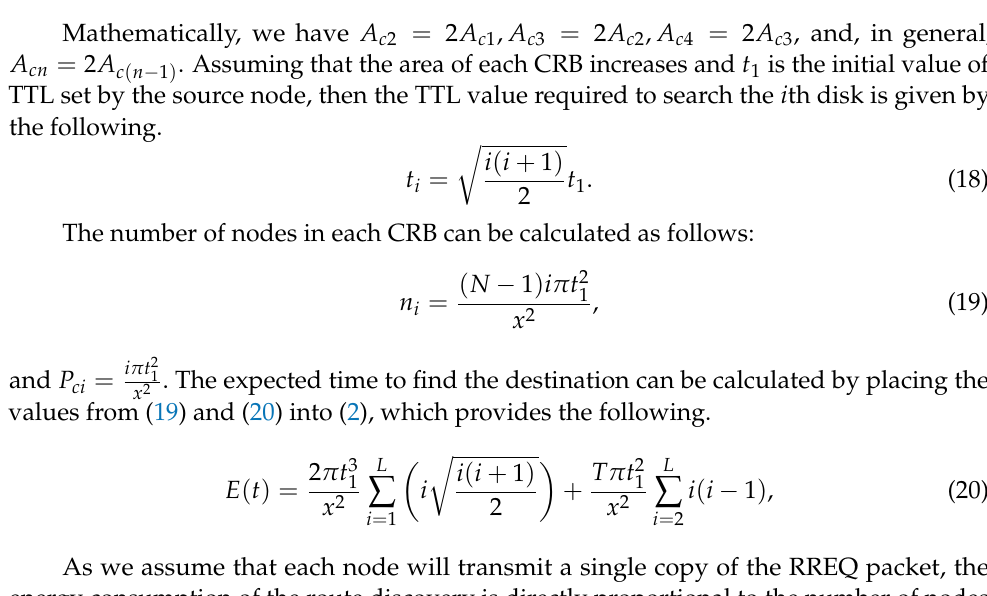
Figure 7. Disks Formation for